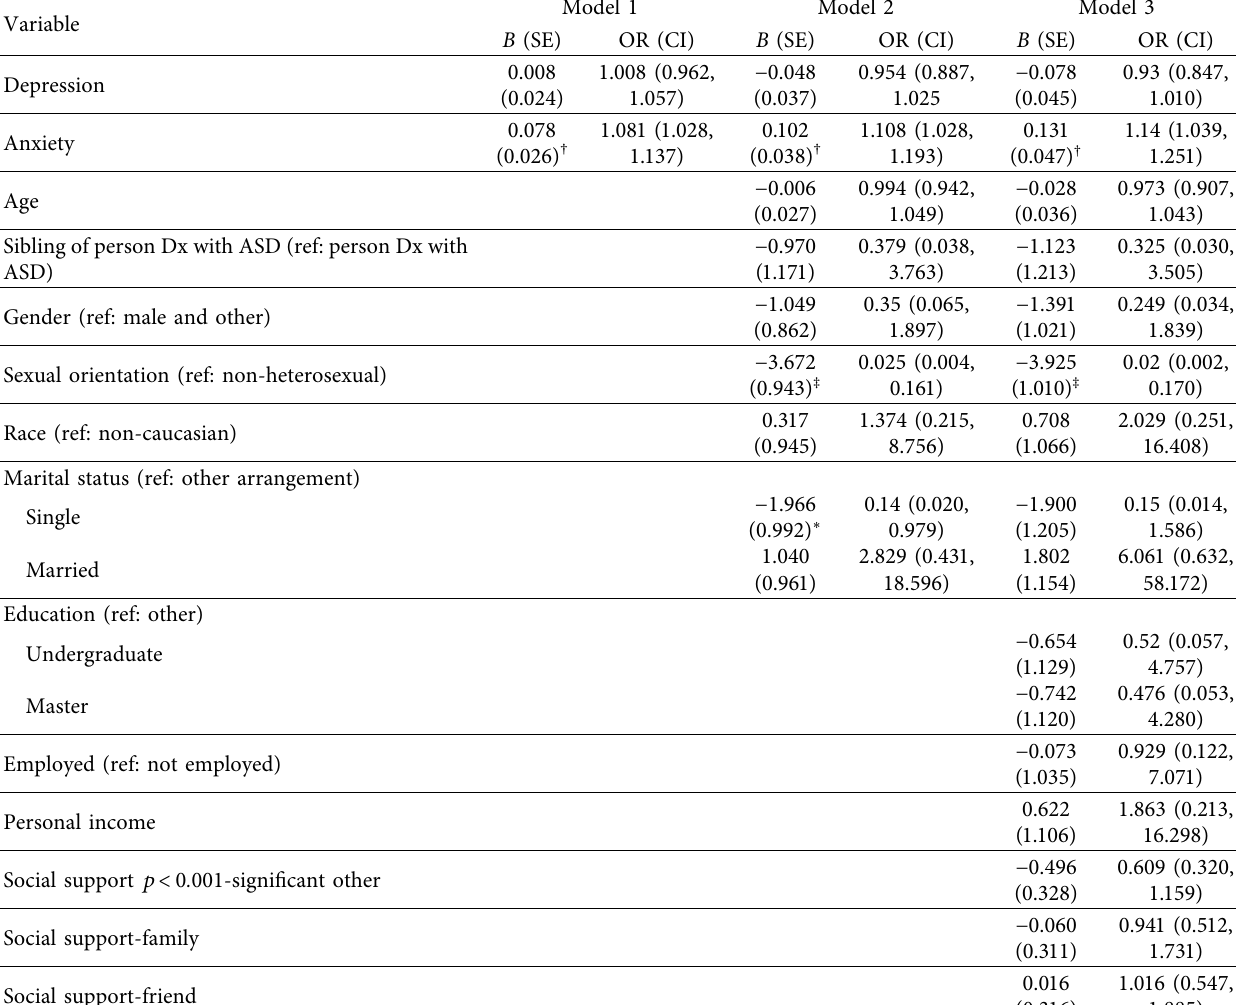
Table 2: Binary regression on variables that impact suicide